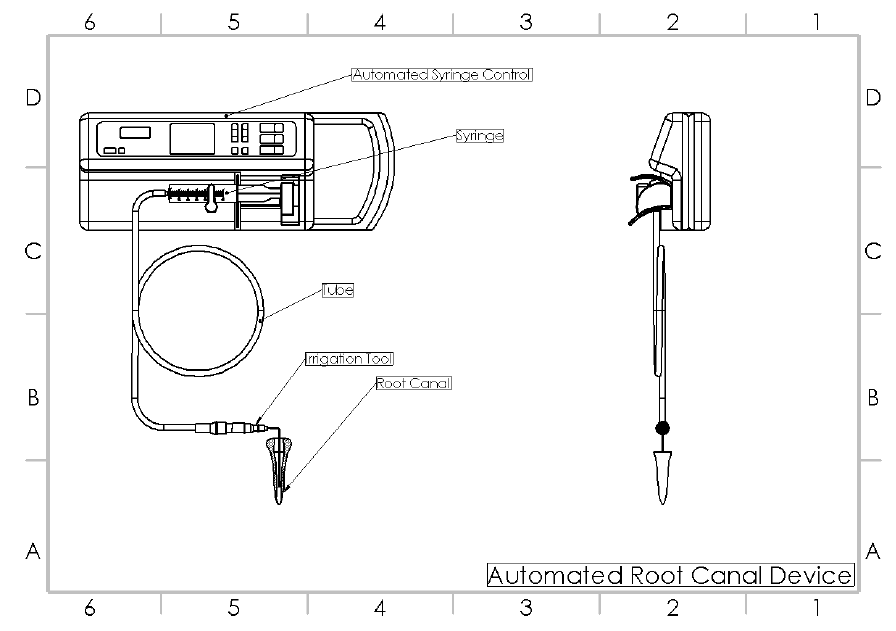
Figure 2. Automated root canal irrigation device [13].